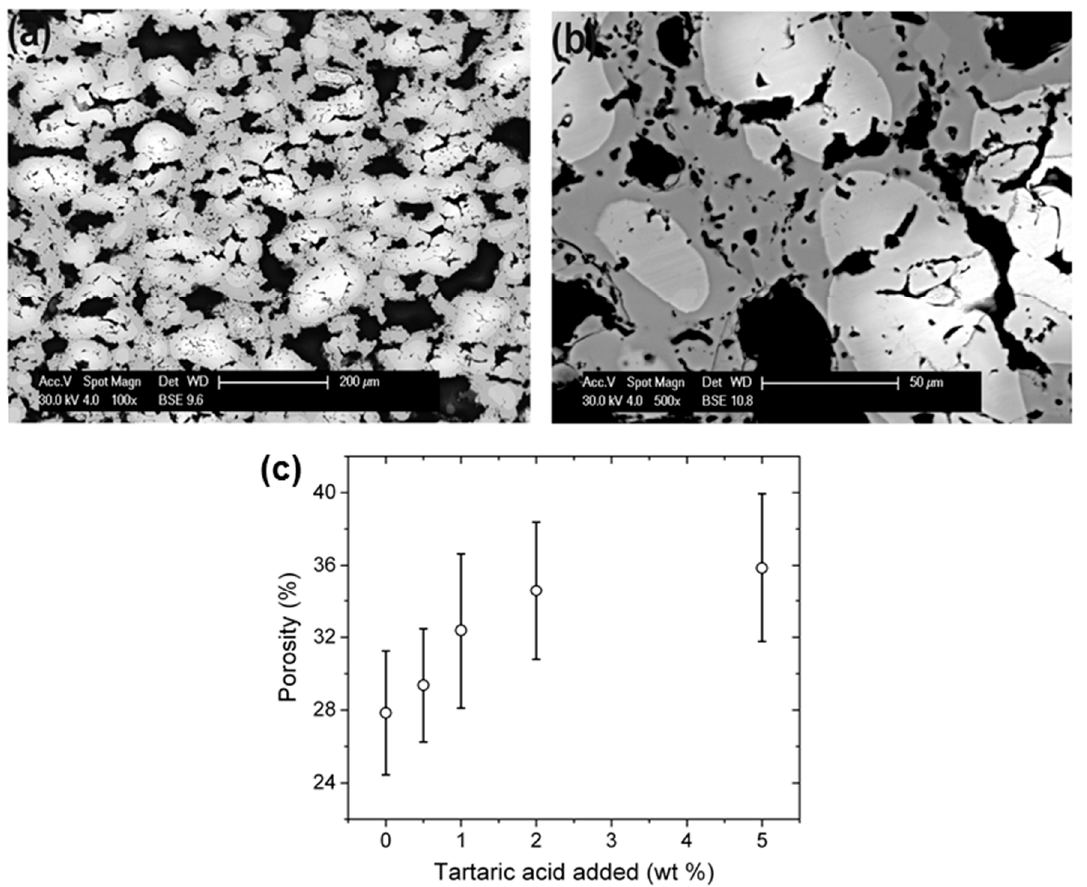
Figure 1. ( a , b ) FE-SEM images of Fe-Al intermetallic foams formed by elemental powders sintered with the addition of 5 wt % tartaric acid; ( c ) the porosity of the foams vs. the amount of added tartaric acid.